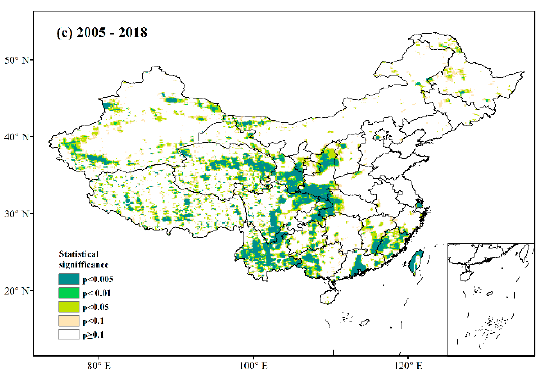
Figure 3. The significance levels of linear trends over China: ( a ) from 2005–2012; ( b ) from 2013–2018; and ( c ) from 2005–2018.